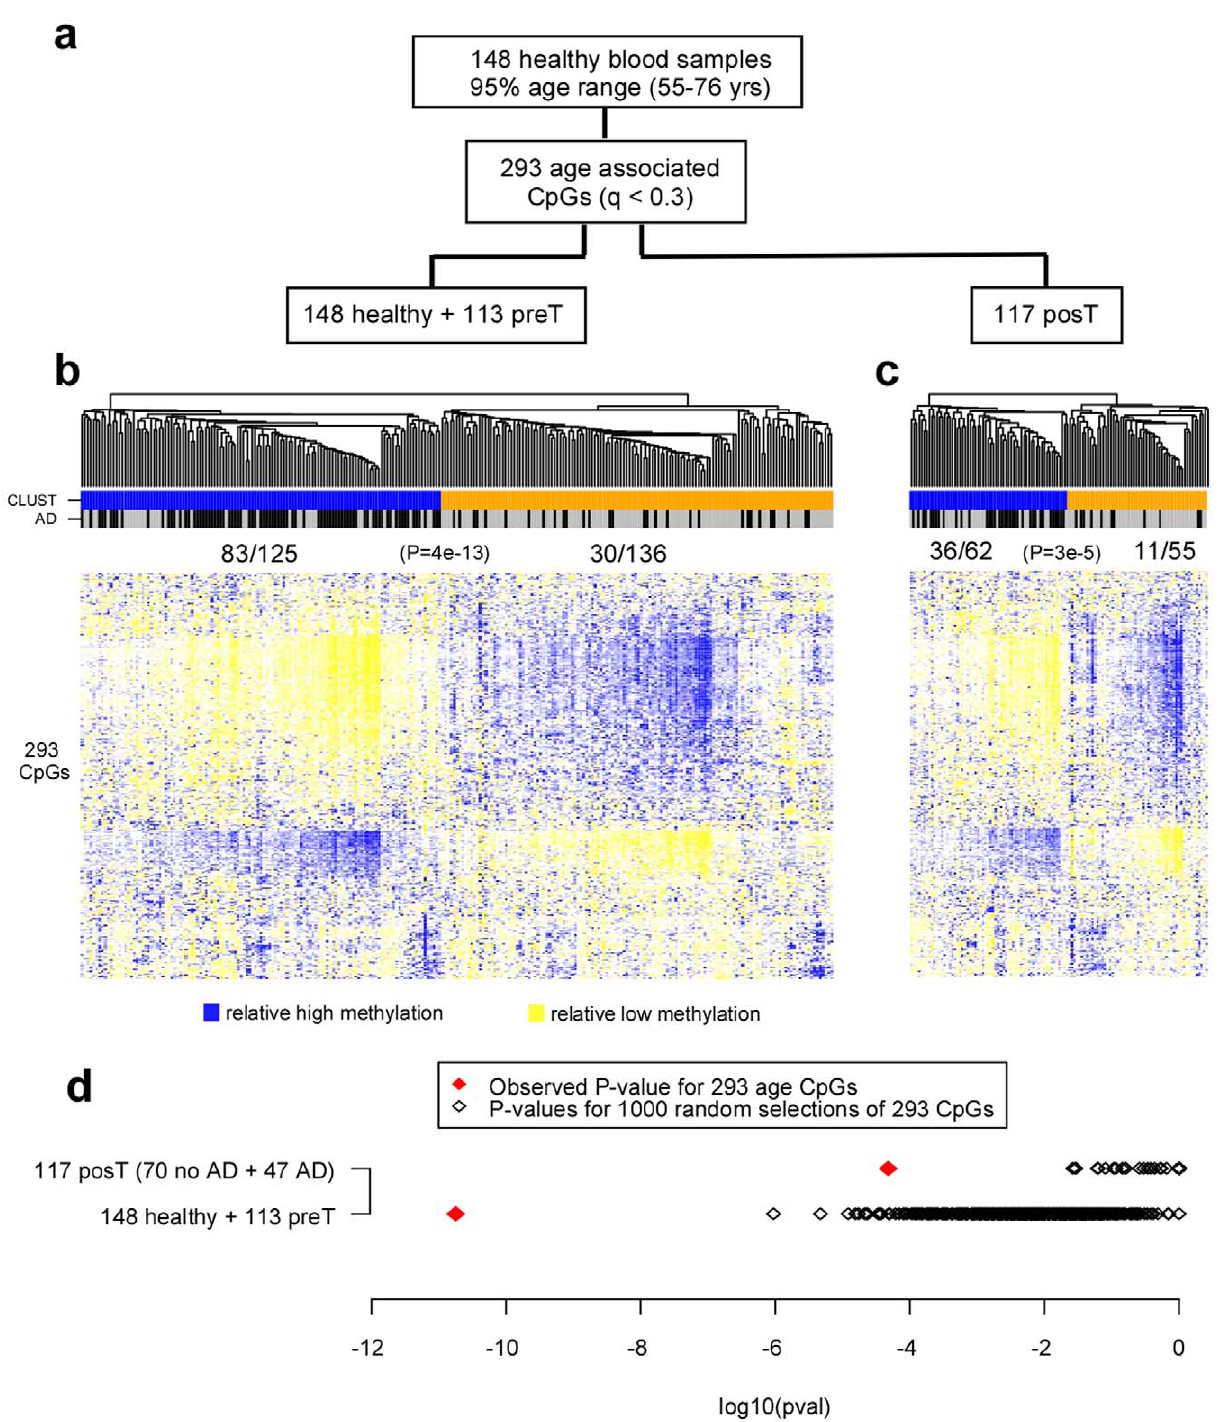
Figure 4. Clustering of samples over age-associated CpGs. a ) Multivariate linear regression of age in 148 healthy blood samples against CpG methylation profiles adjusting for BSC efficiency, batch and DNA input effects, identified 293 CpGs at q(FDR) , 0.3. b ) Hierarchical clustering of the 148 healthy controls and 113 pre-treatment (preT) cases over the 293 CpGs. The two main clusters (CLUST) predicted by the algorithm are labelled as blue and orange. Case control status is indicated as active disease (AD): case=black, control=grey. c ) Hierarchical clustering of 117 post-treatment cases over same 293 CpGs. Of the 117 post-treatment cases, 47 and 70 had recurrent (black) and no recurrent (grey) active disease (AD) at sample draw, respectively. The two main clusters (CLUST) predicted by the algorithm are labelled as blue and orange. In the heatmaps, CpG specific methylation b - values were standardised to zero mean and unit variance for sake of clarity (blue: high relative methylation, yellow=low relative methylation). In panels b) and c) we give the number of samples with active disease at sample draw in each cluster, and give the corresponding Fisher’s exact test P- value. d ) Comparison of observed P-values with those obtained by 1000 random selections of 293 CpGs. P-values were computed from Fisher’s exact test for the two clusters inferred from applying a Gaussian mixture model [43].